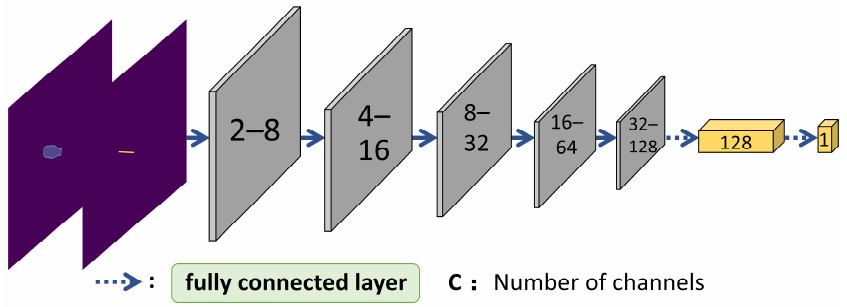
Figure 10. Scoring network architecture.